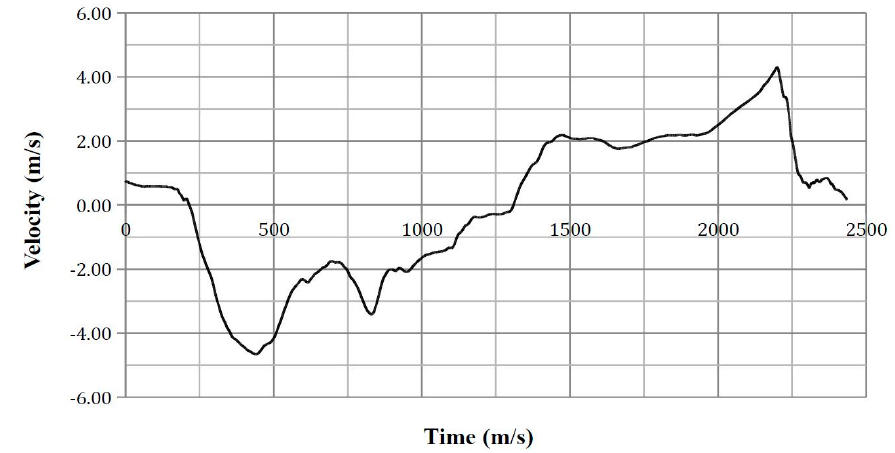
Figure A19. ATD Position 2 lower spine y-axis velocity.